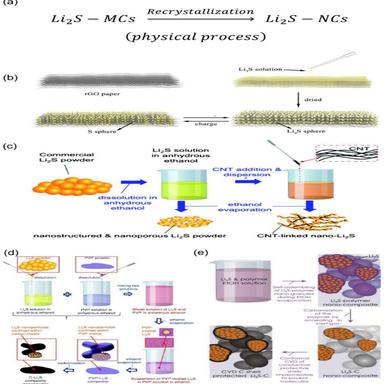
The equation (a) and schematic (b–d) illustrating different methods of making Li2S-C composite materials via recrystallization of commercial Li2S-MCs. (b) Li2S/rGO paper ; (c) Li2S-MWCNTs ; (d) Li2S@C; (e) Li2S@HC. Reproduced from Refs. with permission from the American Chemical Society, Royal Society of Chemistry, and Wiley.